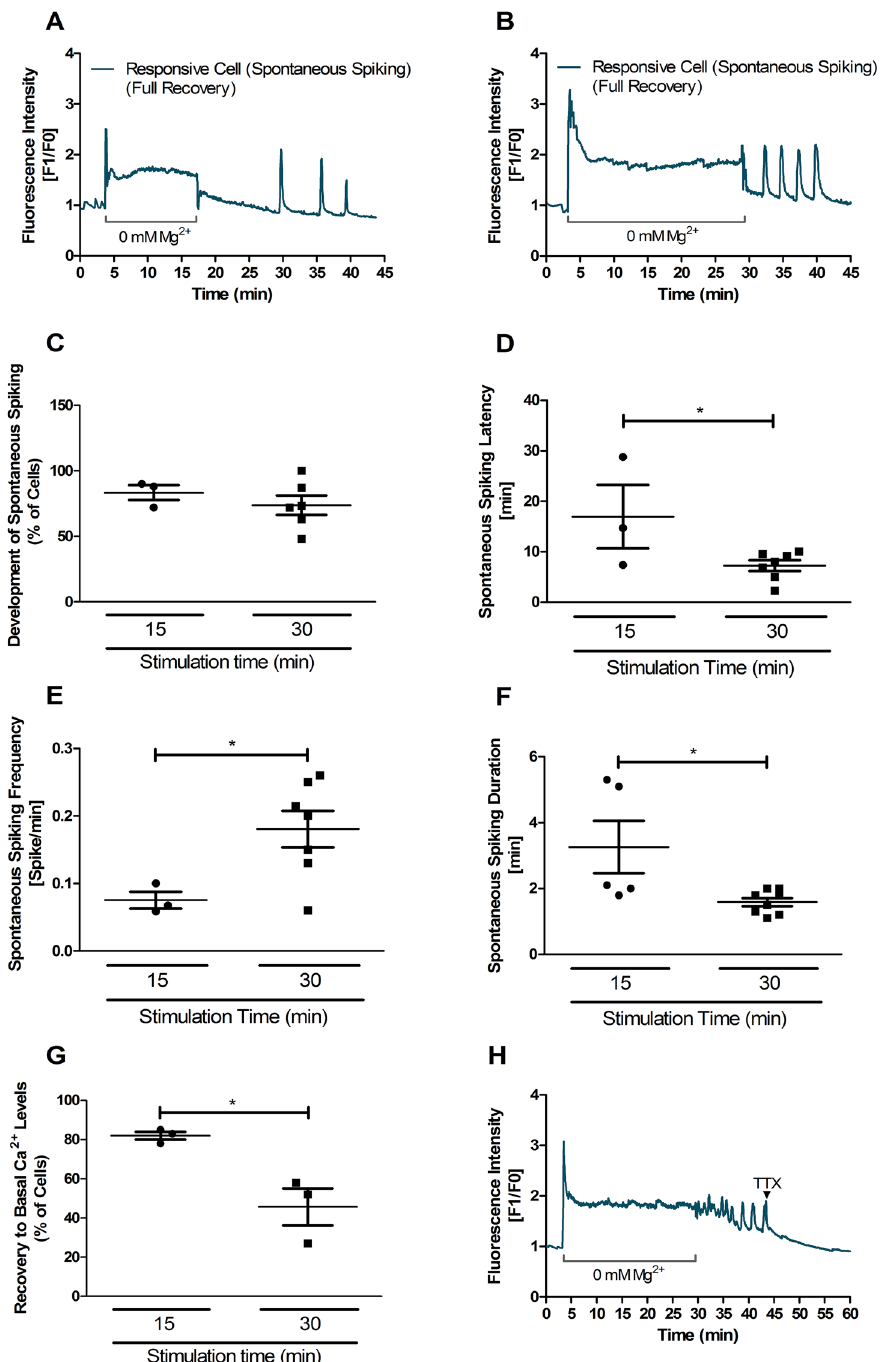
Figure 5. Different periods of incubation in [Mg 2+ ] 0 medium induce spontaneous calcium oscillations with distinct characteristics. ( A , B ) Cultured hippocampal neurons (15 DIV) were analysed by single cell calcium imaging using the fluorescent Ca 2+ indicator Fluo-4, with Spinning Disk microscopy. The cells were initially incubated in control salt solution for 3 min to determine the baseline fluorescence level. The solution was then replaced with [Mg 2+ ] 0 medium and the cells were further incubated under these conditions for 15 min ( A ) or 30 min ( B ). After this incubation period the cells were further incubated in control salt solution. Fluo-4 fluorescence was recorded for the duration of the experiment and for each time point the results are presented as the normalized intensity of Fluo-4 fluorescence (Fluorescence for a given time point divided by the baseline fluorescence). ( C , G ) Analysis of the response profile of cells that developed spontaneous calcium transients after 15 min (n = 60 cells) and 30 min (n = 90 cells) of stimulation with [Mg 2+ ] 0 medium. The following parameters were analysed: ( C ) Percentage of cells that develop spontaneous calcium transients, ( D ) latency period, ( E ) frequency and ( F ) duration of calcium transients, and ( G ) percentage of cells that recover to basal calcium levels. ( H ) Similar experiment to that depicted in B but with TTX (1 µM) added at the indicated time point. The results are representative of at least three independent experiments performed in distinct preparations. Values are the mean ± SEM. Statistical analysis was performed by unpaired Student’s t test, * p <